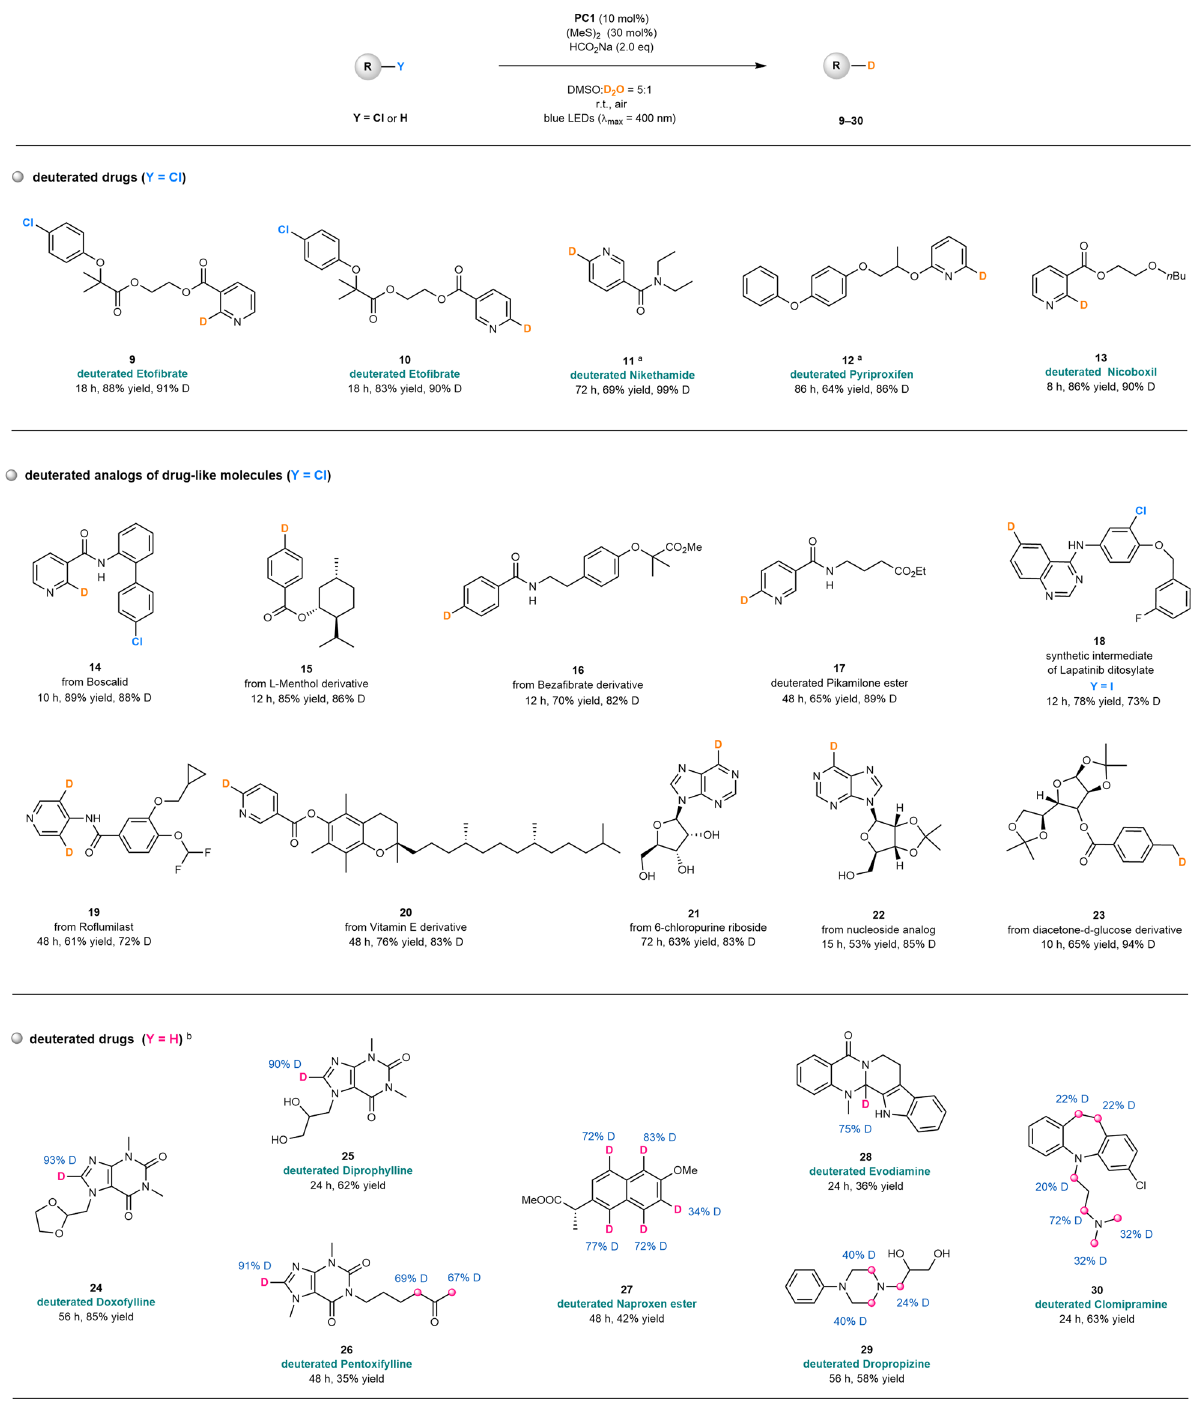
Fig. 9 Synthetic application to D-labeled bioactive molecules and drugs. a PC4 (20 mol%), ( n PrS) 2 (30 mol%), in argon. b PC2 (10 mol%), ( n PrS) 2 (60 mol%), HCO 2 Na (4.0 eq). PC, photocatalyst; eq, equivalent; r.t., room temperature; DMSO, dimethyl